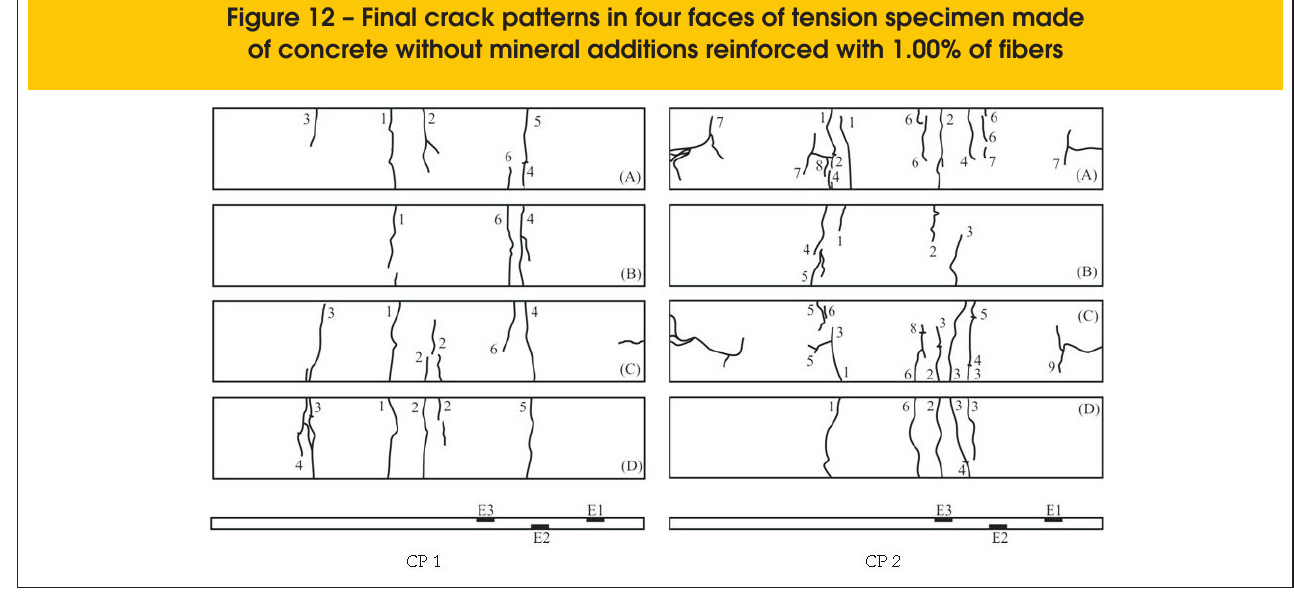
Figure 12 – Final crack patterns in four faces of tension specimen made of concrete without mineral additions reinforced with 1.00% of